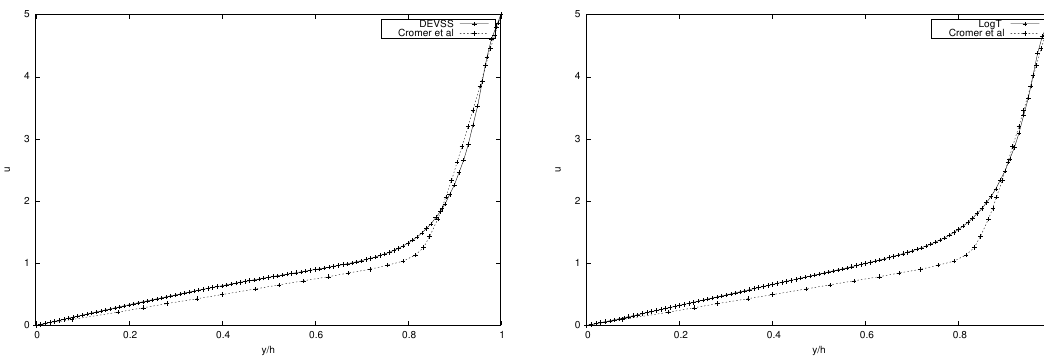
Figure 14. Velocity profile for k = 1 using the DEVSS method (compared with references [35] (RHS)).